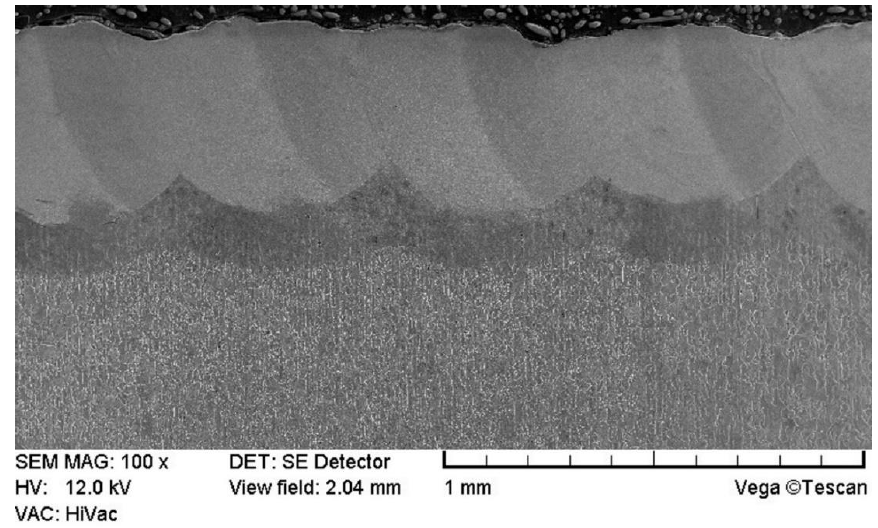
Figure 3. Microstructure of W–Cr coating produced using laser processing of precoat applied on steel substrate .